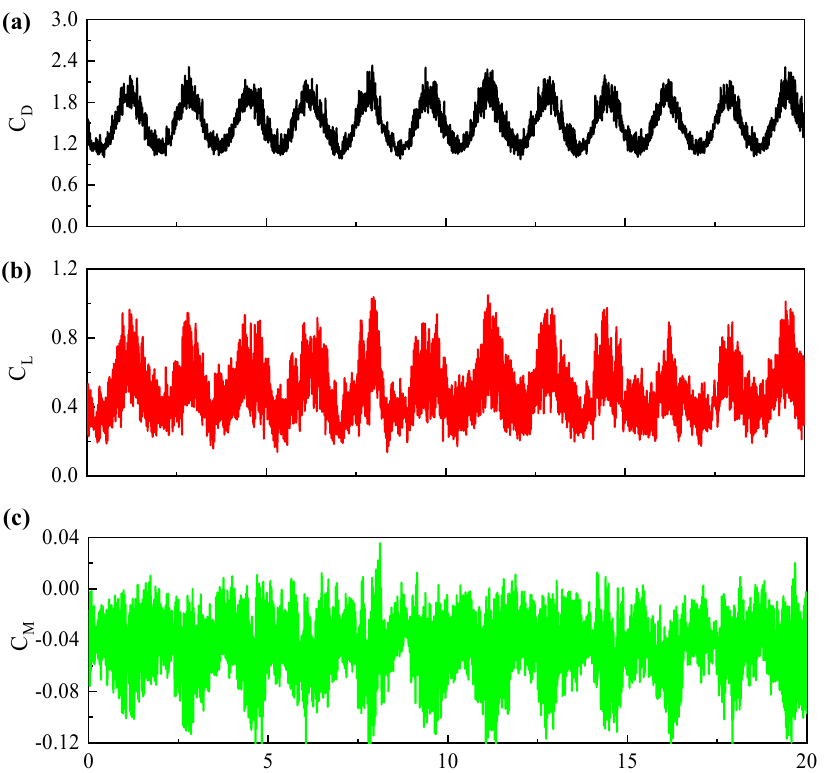
Figure 5. Time history of ( a ): C D , ( b ): C L , and ( c ): C M in SF (0.6, 0.125), at AoA = 4 ◦ .